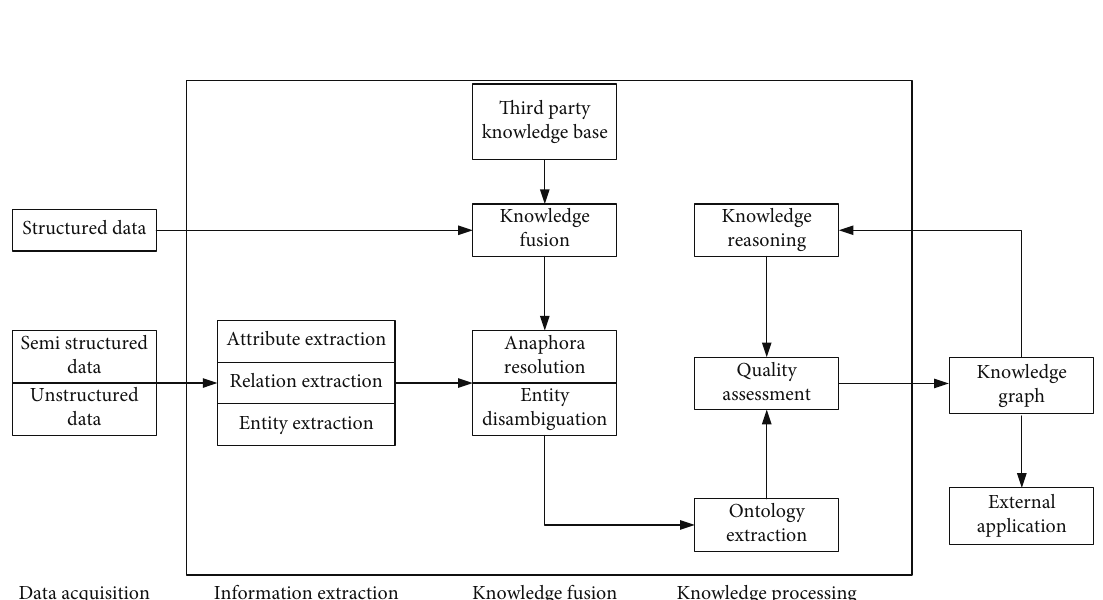
Figure 3: Knowledge graph